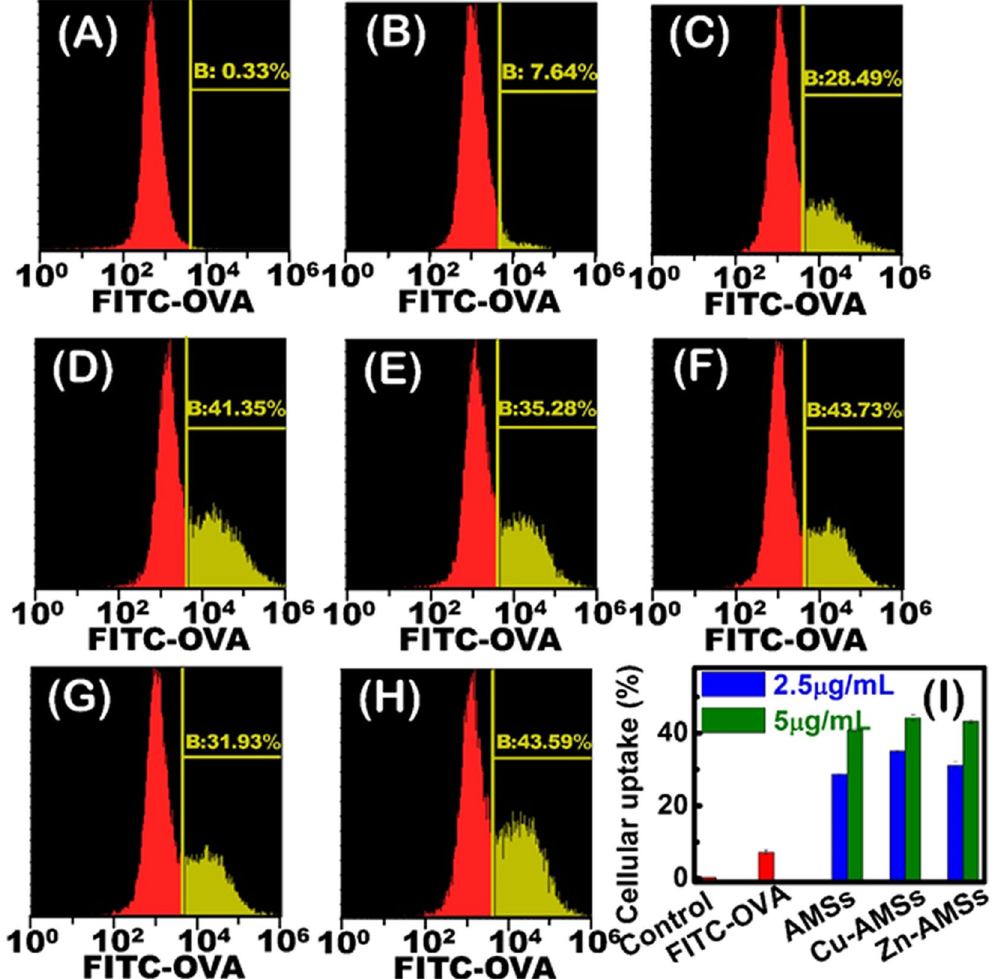
Figure 3. Cellular uptake of FITC-OVA by THP-1 differentiated macrophages. ( A ) Histograms for control, ( B ) soluble FITC-OVA, ( C , D ) FITC-OVA-AMSs (particle concentration: ( C ), 2.5 μ g/mL; ( D ) 5 μ g/mL), ( E , F ) FITC-OVA-Cu-AMSs (particle concentration: ( E ) 2.5 μ g/mL; ( F ) 5 μ g/mL) and ( G , H ) FITC-OVA-Zn-AMSs (particle concentration: ( G ) 2.5 μ g/mL; ( H ) 5 μ g/mL). ( I ) Semiquantatative analysis for control, soluble FITC- OVA, FITC-OVA-AMSs, FITC-OVA-Cu-AMSs and FITC-OVA-Zn-AMSs at different particles concentration (2.5 and 5 μ